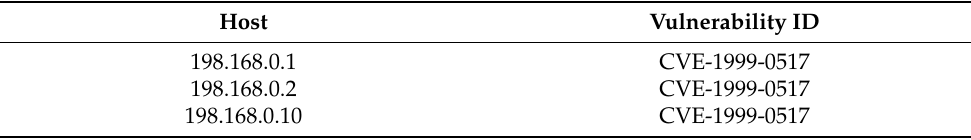
Table 5. Vulnerability